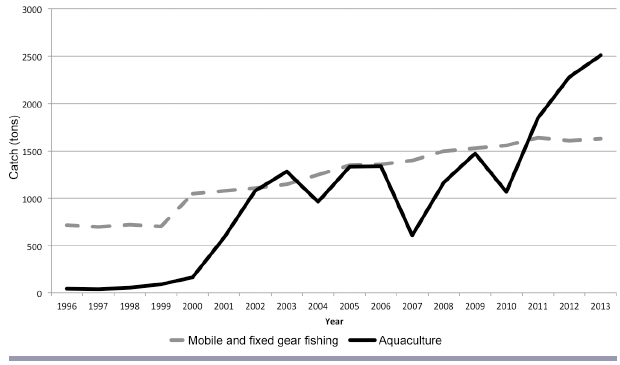
Fig. 3 . Fisheries and aquaculture production in the Cau Hai lagoon, 1996-2013. Data provided by Department of Agriculture and Rural Development, Phu Loc